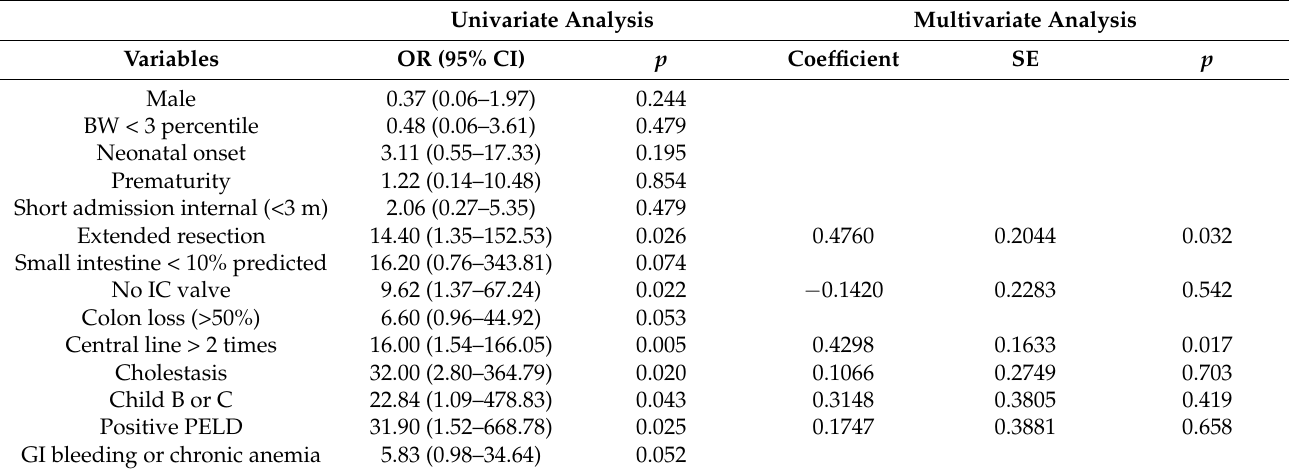
Table 6. Risk factor analysis for HPN dependence.